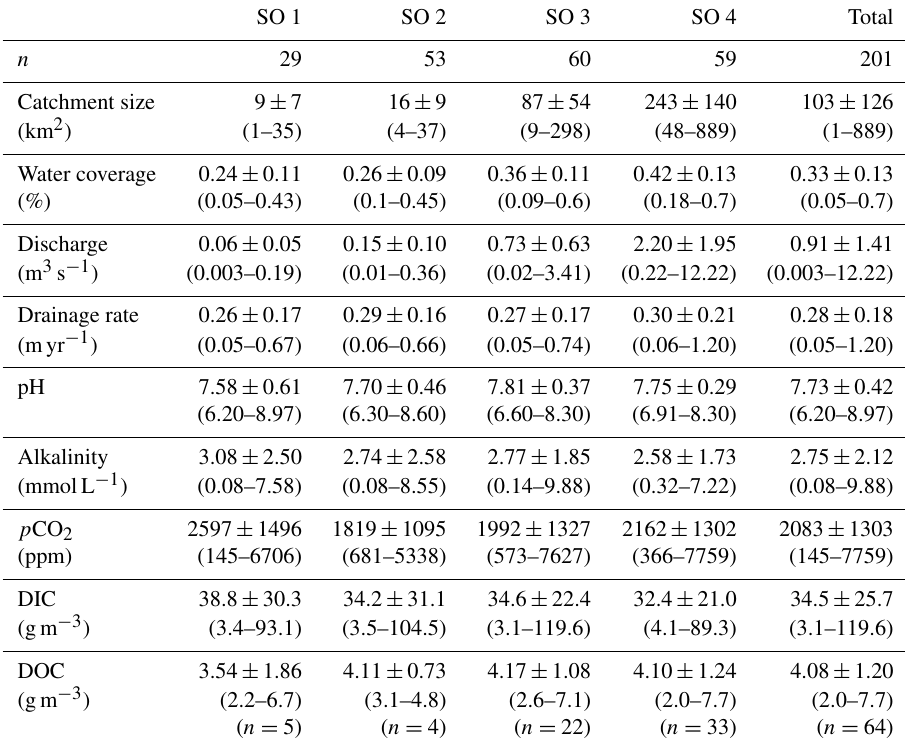
Table 1. Major hydrological characteristics, p CO 2 , DIC and DOC concentrations averaged over stream orders (SO) and for all sampling sites (Total). All values are provided as mean ± SD (standard deviation) of the annual mean observations, ranges are given in brackets and n is the number of observations.